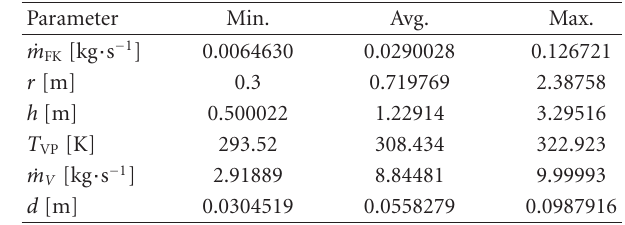
Table 6: The best values of optimized parameters by SOMA, DE.